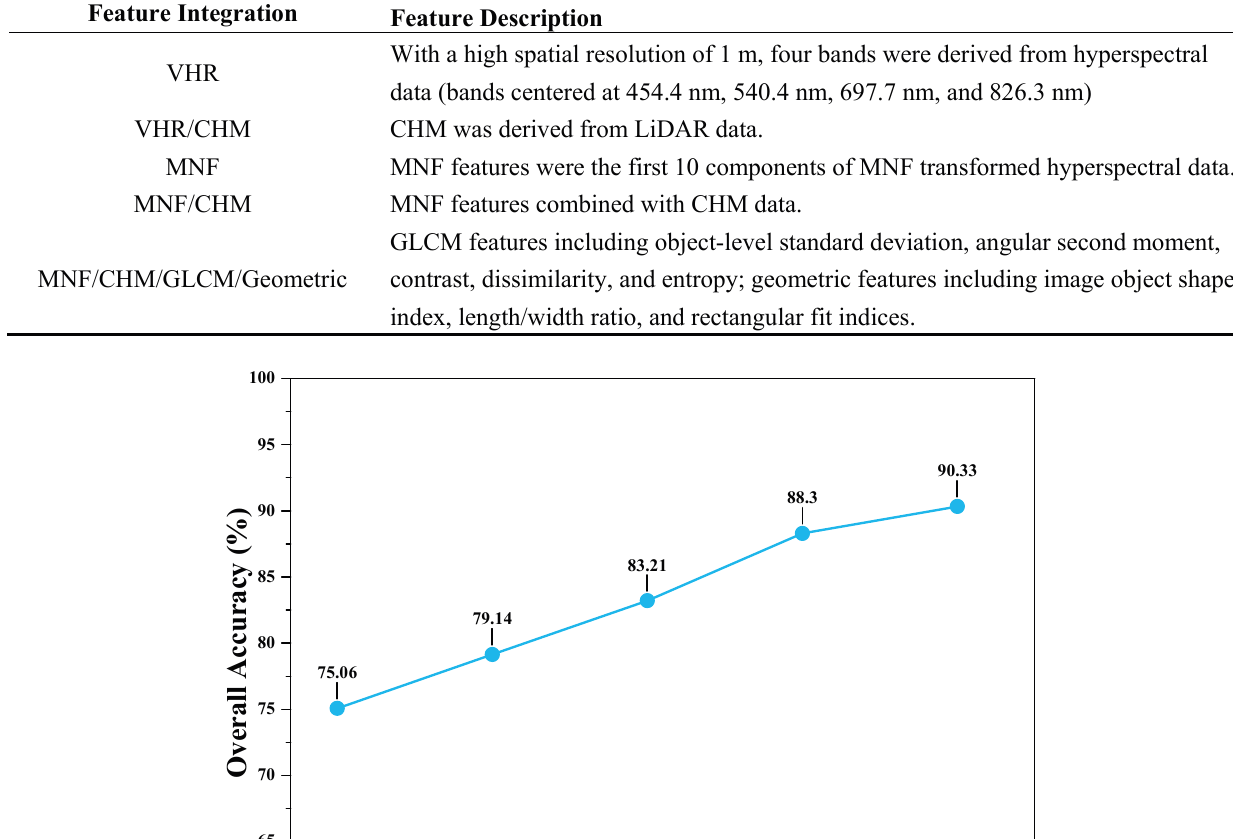
Table 5. Summary of classification schemes.